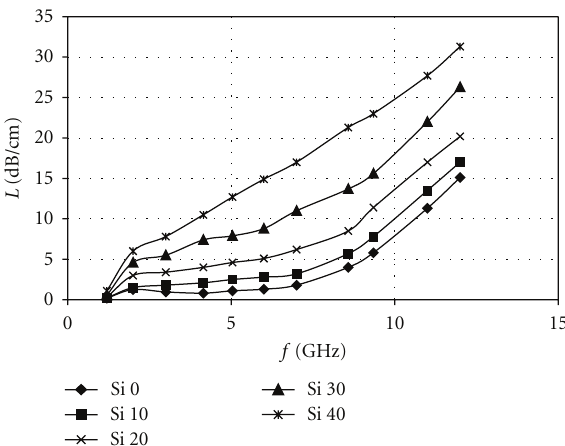
Figure 7: Frequency dependence of the reflection coe ffi cient at various filler content in the composites.